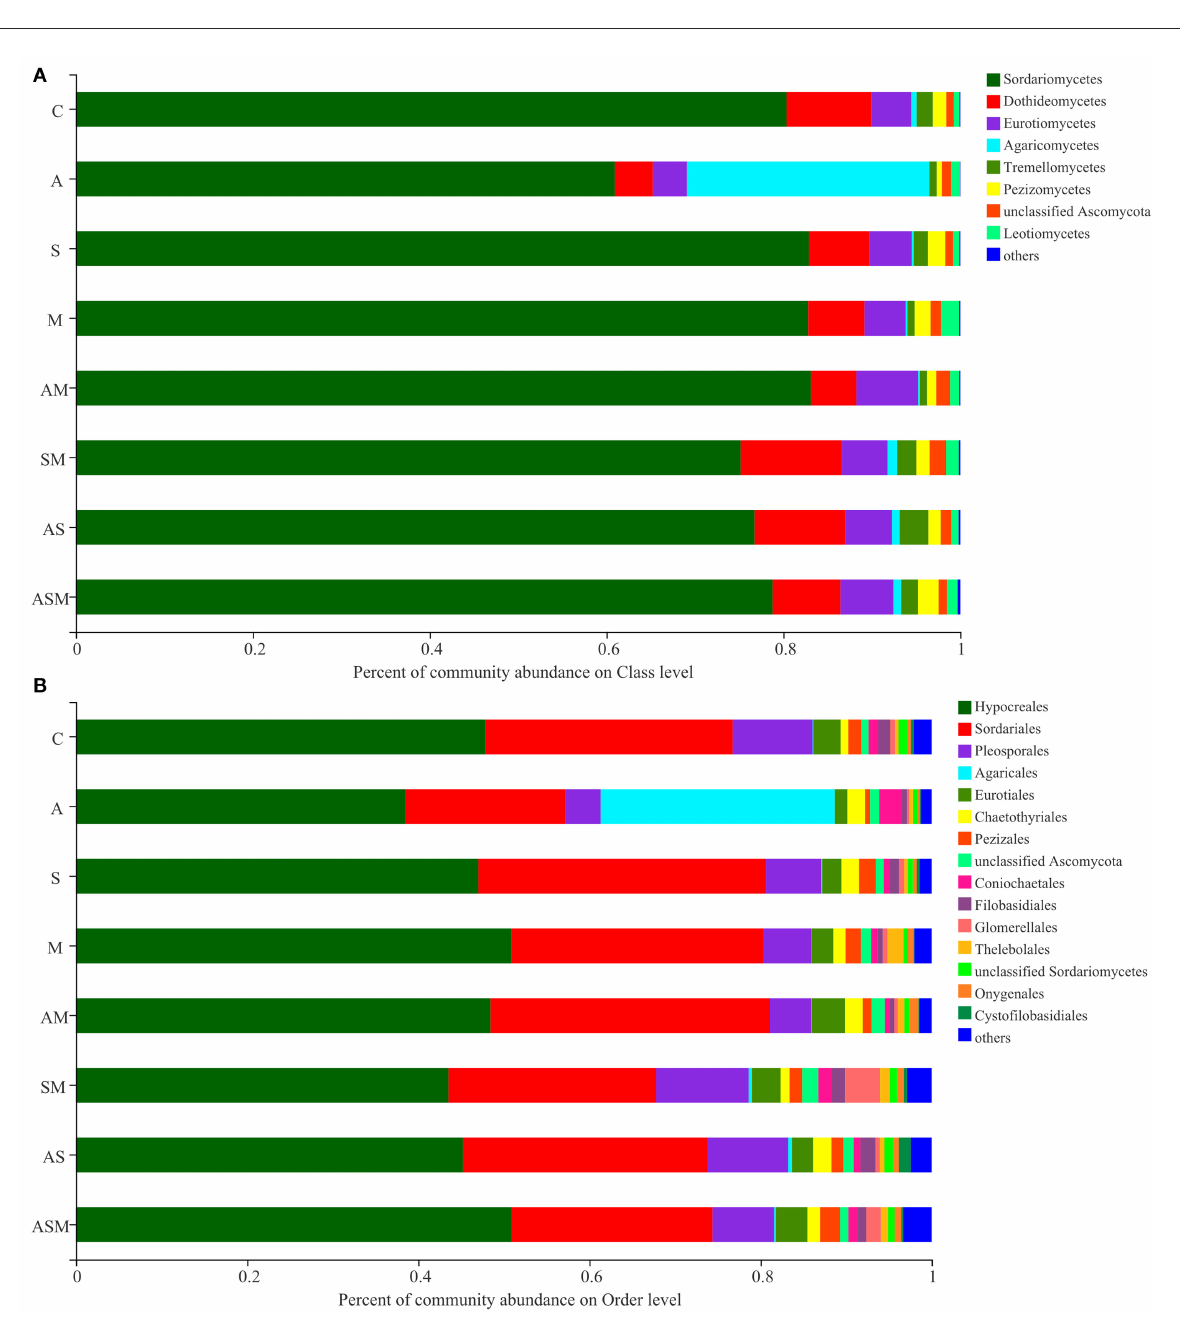
FIGURE5 Relative abundances of soil fungi on class (A) and order (B) levels of A. adsurgens . The fungal class and order represents < 0.01% of the total reads and were all assigned to “Others.” C, non-inoculated control; A, inoculation with Alternaria chlamydospora ; S, inoculation with Sarocladium kiliense ; M, inoculation with Monosporascus sp.; AS, co-inoculation of Alternaria chlamydospora and Sarocladium kiliense ; AM, co-inoculation of Alternaria chlamydospora and Monosporascus sp.; SM, co-inoculation of Sarocladium kiliense and Monosporascus sp.; ASM, combination inoculation of the three